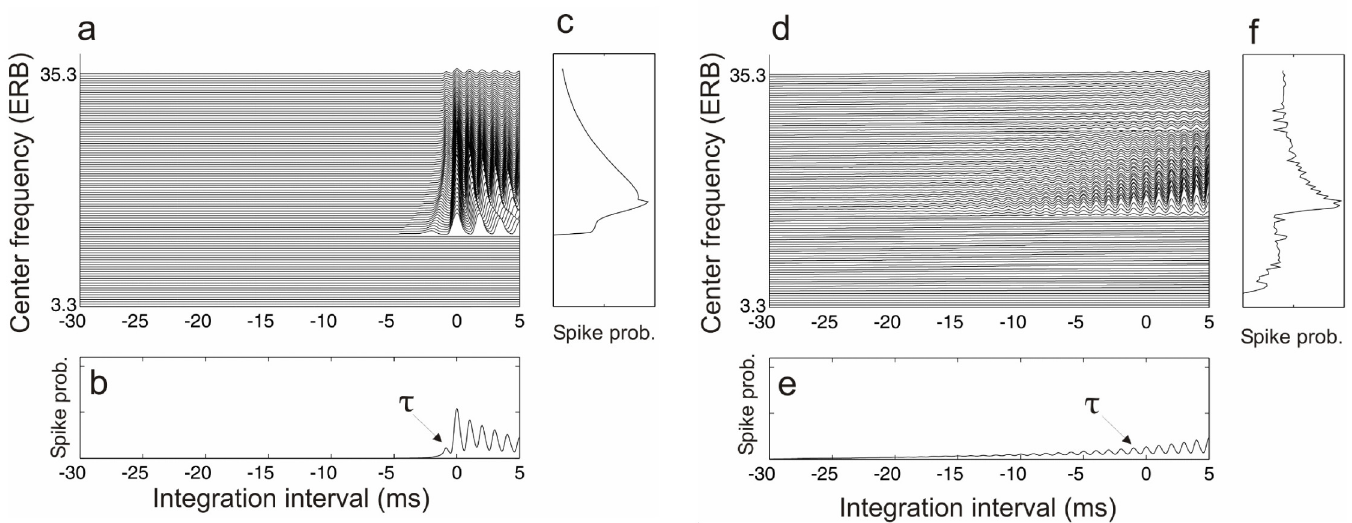
Fig 3. Output of the auditory image model for the T 1/2 = 4ms ramped and damped sinusoids. Auditory Image Models ’ output for damped (a – c) and ramped (d – f) trains ( T 1/2 = 4ms) at the time point of the same envelope height. Panels a) and d) show the stabilized auditory image (SAI) over time in each cochlear frequency channel. Panels c) and f) represent the spike probability averaged over time. Panels b) and e) show the summarised activity of all channels in the auditory image. The integration interval is the inverse of the carrier frequency applied [11], thus it shows a peak at τ = − 1ms in the figure. The height of this peak predicts the perceived carrier